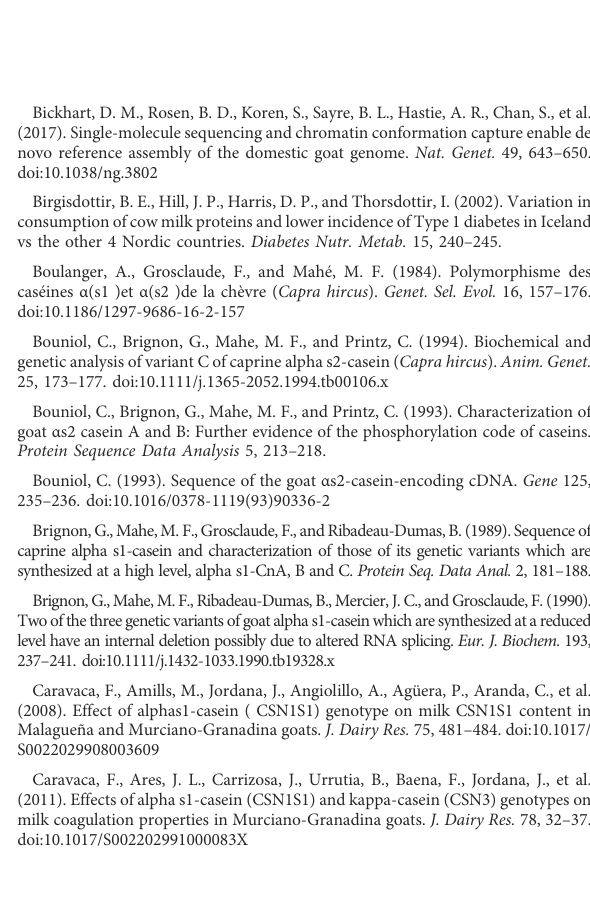
SUPPLEMENTARY TABLE S3 Frequency of CSN2 variants in different goat breeds and countries. SUPPLEMENTARY TABLE S4 Frequency of CSN1S2 variants in different goat breeds and